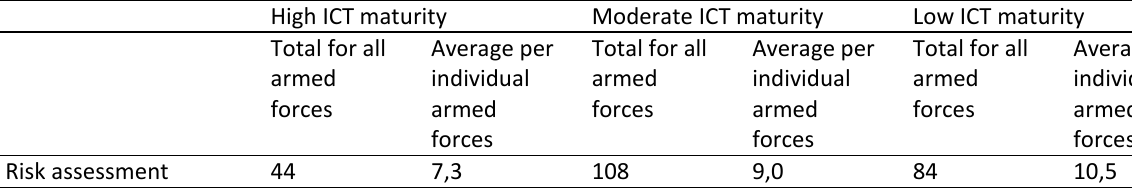
Table 4. Risks related to ICT maturity.